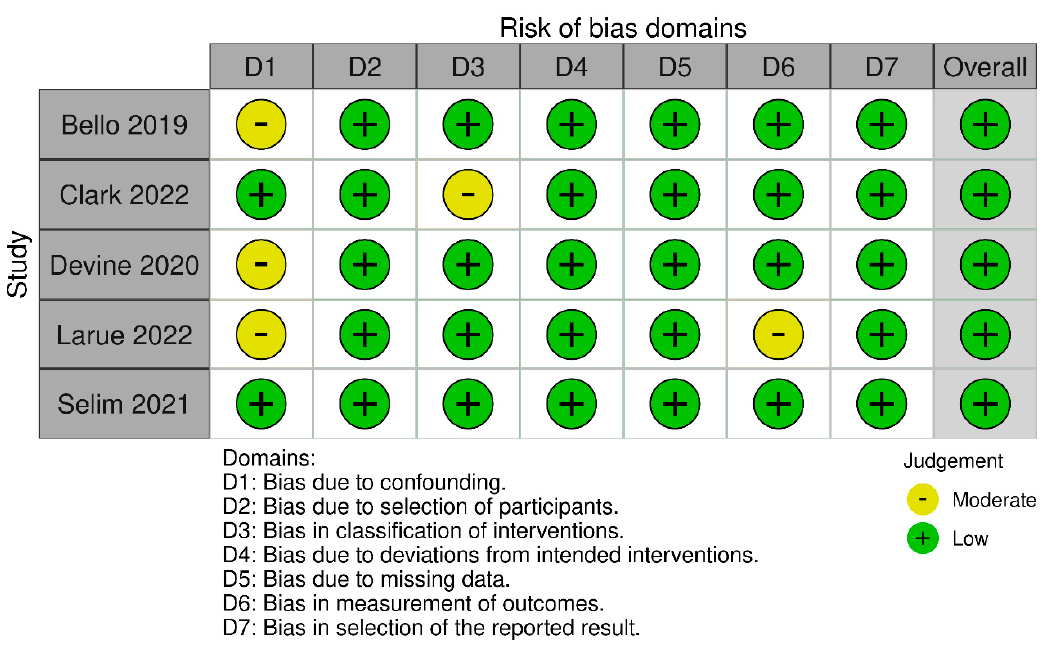
Figure 2. ROBINS − I evaluation of included studies. ROBINS − I risk of bias in non − randomised studies of interventions [16–20].